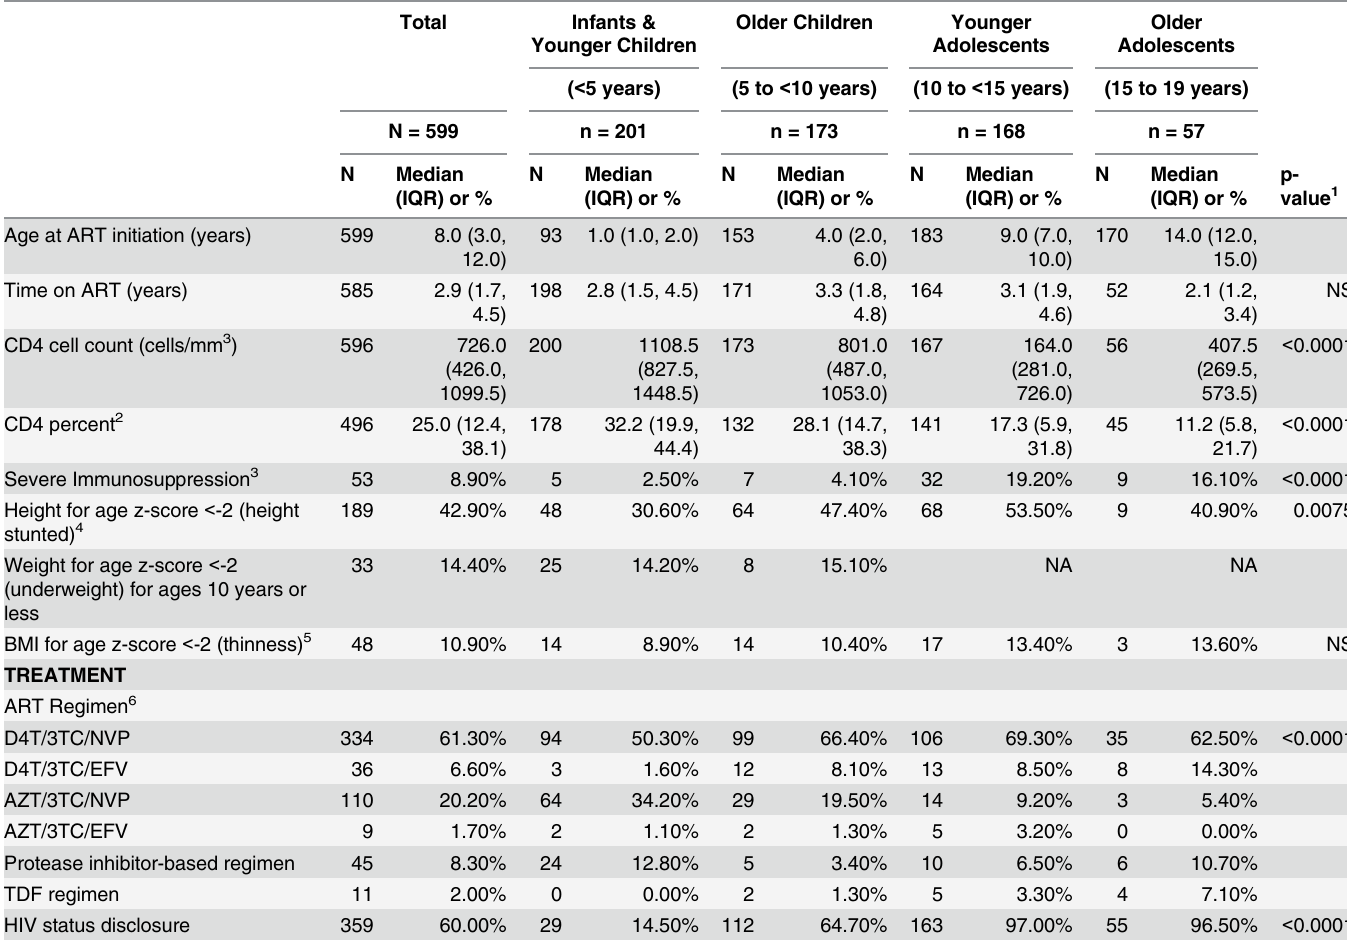
Table 2. Immunologic and clinical outcomes on ART, overall and by age at ART